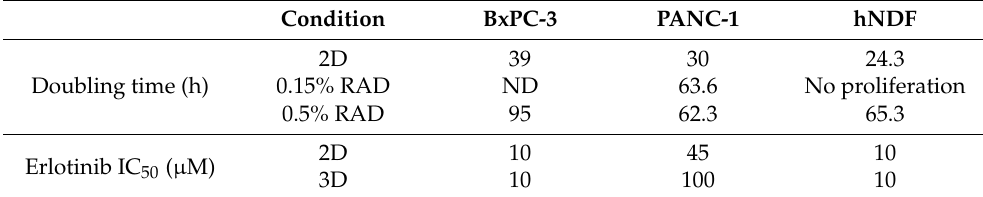
Table 1. Doubling time (h) and erlotinib sensitivity in 2D and 3D